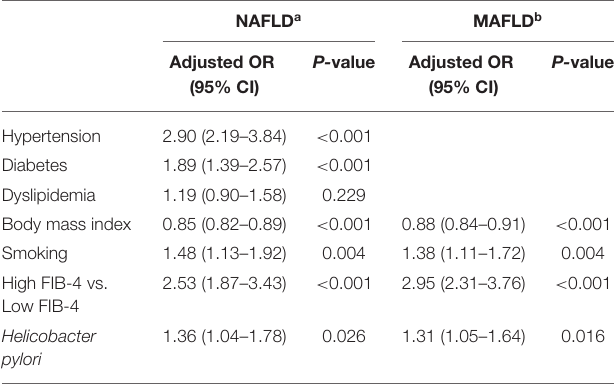
TABLE 3 | Multivariate analyses of the risk for arterial stiffness in subjects with